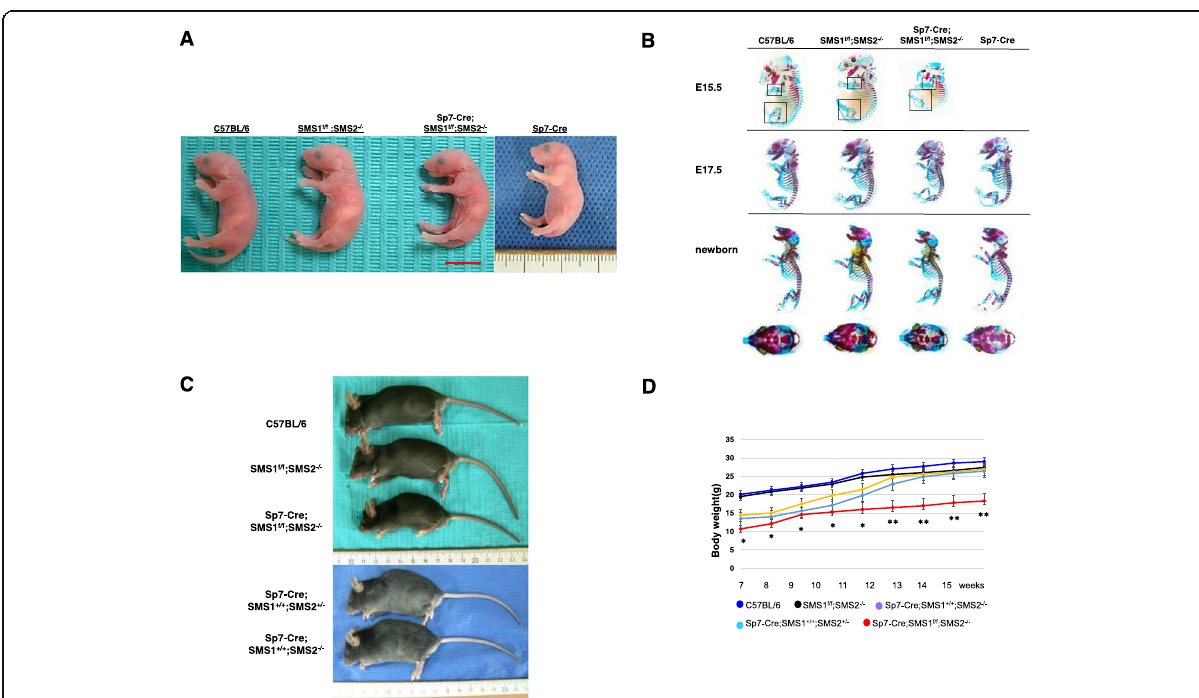
Fig. 1 Skeletal changes and growth retardation in Sp7-Cre;SMS1 f/f ;SMS2 − / − mice. a Gross appearance of C57BL/6, SMS1 f/f ;SMS2 − / − , Sp7- Cre;SMS1 f/f ;SMS2 − / − and Sp7-Cre mice at p1. Sp7-Cre;SMS1 f/f ;SMS2 − / − mice are small. Bar = 1 cm. b Skeletons from E15.5-E17.5 embryos and newborns (p1) of C57BL/6, SMS1 f/f ;SMS2 − / − , Sp7-Cre;SMS1 f/f ;SMS2 − / − and Sp7-Cre mice. Embryos and newborns were stained with Alizarin red and Alcian blue. Note the delayed mineralization of the limbs in the Sp7-Cre;SMS1 f/f ;SMS2 − / − E15.5 embryo compared with that of C57BL/6 and SMS1 f/f ;SMS2 − / − mice (black square). Dorsal views of skulls of newborns showed that calvarial bone was hypomineralized in Sp7- Cre;SMS1 f/f ;SMS2 − / − mice. c Gross morphology of C57BL/6, SMS1 f/f ;SMS2 − / − , Sp7-Cre;SMS1 f/f ;SMS2 − / − , Sp7-Cre;SMS1 +/+ ;SMS2 +/ − , and Sp7- Cre;SMS1 +/+ ;SMS2 − / − male mice at 15 weeks after birth. d Body weight of C57BL/6, SMS1 f/f ;SMS2 − / − , Sp7-Cre;SMS1 f/f ;SMS2 − / − , Sp7- Cre;SMS1 +/+ ;SMS2 +/ − , and Sp7-Cre;SMS1 +/+ ;SMS2 − / − male mice at indicated time points ( n = 10 for each genotype). * p < 0.05 versus C57BL/6 and SMS1 f/f ;SMS2 − / − . **p < 0.05 versus C57BL/6, SMS1 f/f ;SMS2 − / − , Sp7-Cre;SMS1 +/+ ;SMS2 − / − , and Sp7-Cre;SMS1 +/+ ;SMS2 +/ − . Data are mean ±